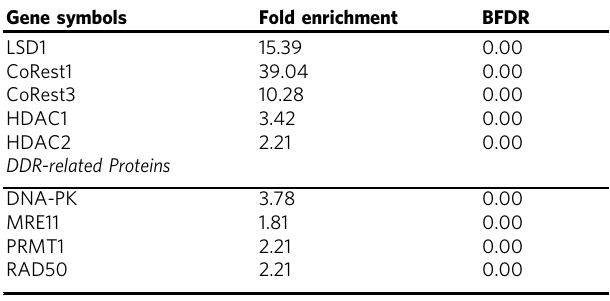
Table 1 Selected G fi 1 binding partners Gene symbols Fold